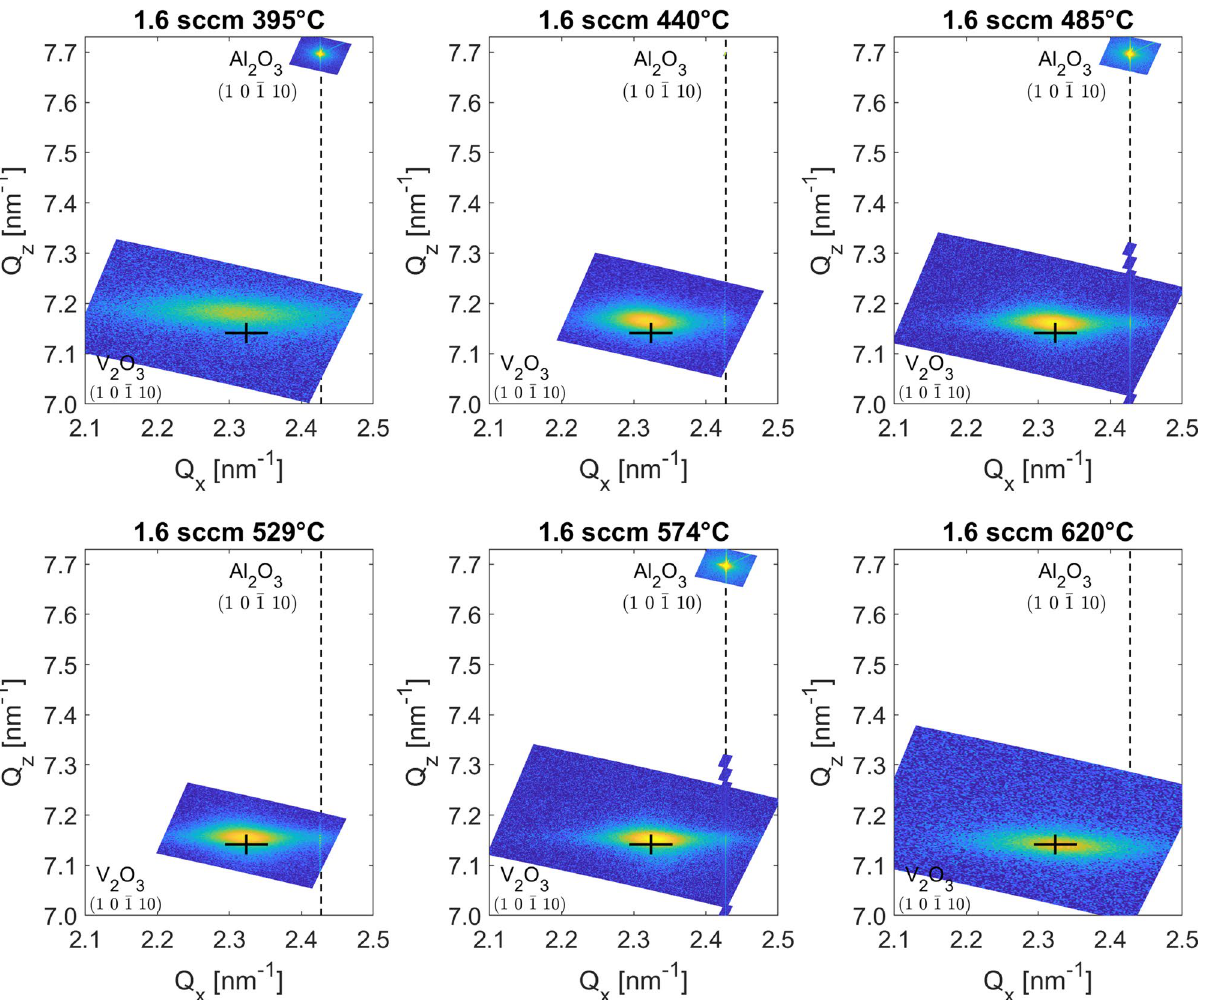
Figure 1. Overview of reciprocal space maps for the V 2 O 3 film series grown at different substrate temperatures. The graphs show scans around the the (1 0 − 1 10) peak location of V 2 O 3 as well as the same peak for the Al 2 O 3 substrate, recorded for calibration of the X-ray instrument. The black cross marks the bulk value for the V 2 O 3 (1 0 − 1 10)